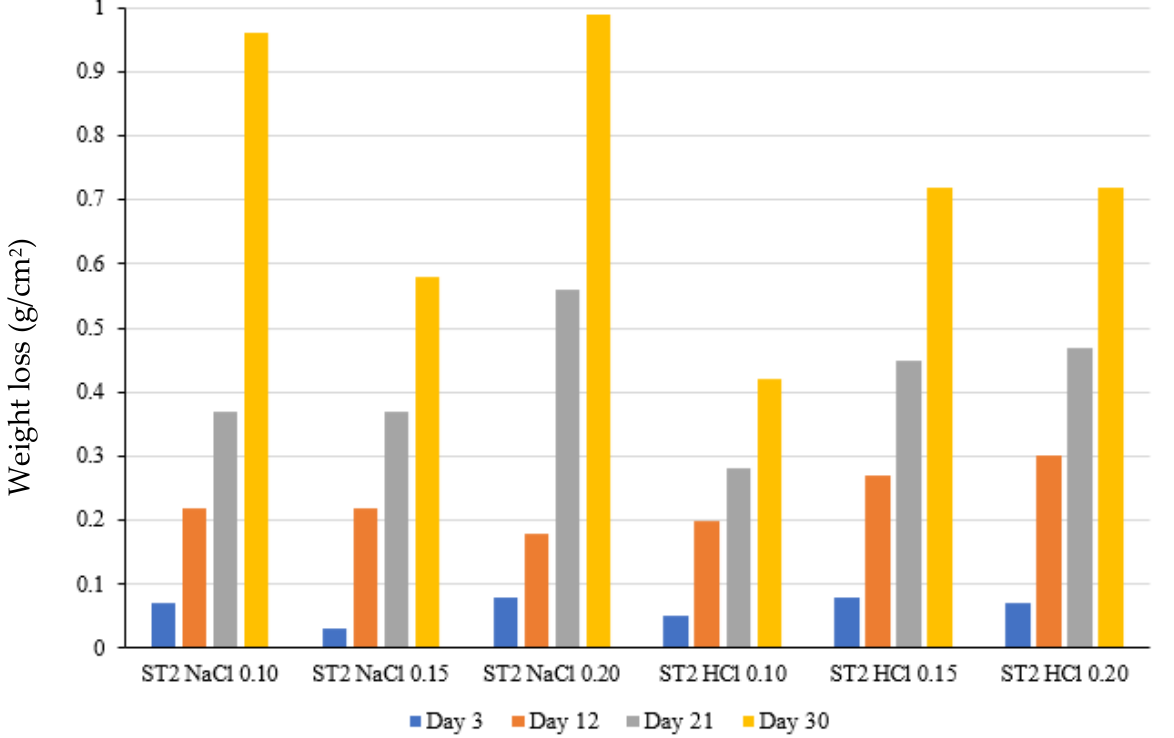
Figure 8. Effect of heat treatment on corrosion behaviour of S T2 (4%).